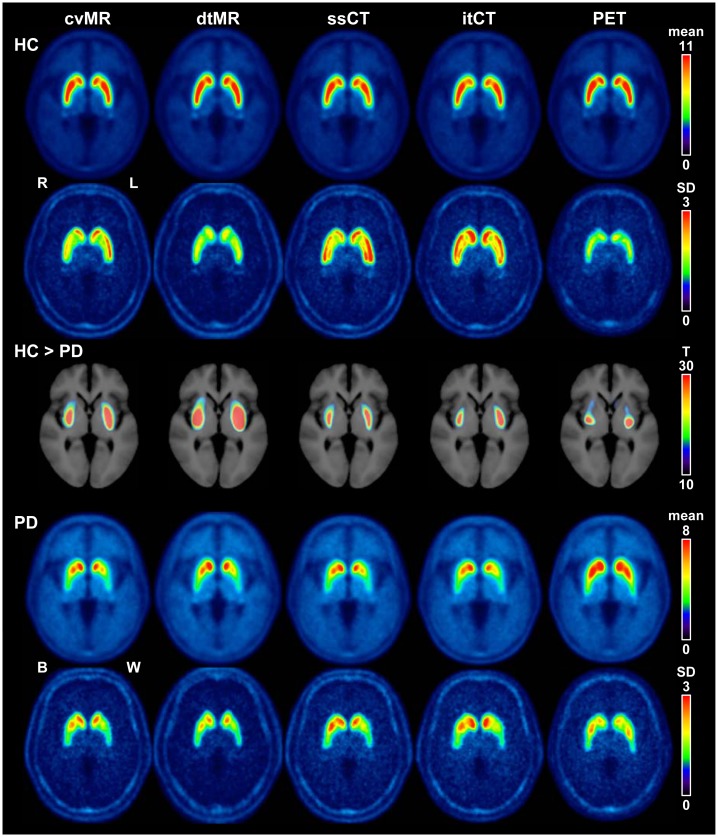
Mean and standard deviation (SD) images of each spatial normalization method and the results of voxel-based comparison between the healthy controls (HC) and Parkinson’s disease (PD) patients.For PD patients images were flipped to locate more affected side (contralateral to the clinically worse side; W) on the left (L) and the less affected side (contralateral to the clinically better side; B) on the right (R). The mean images of controls and PD patients derived from four structure-guided spatial normalization methods are similar. However, the caudate and anterior part of the putamen of PD patients were overestimated, and thereby, the mean image of PD patients derived from the PET-guided method shows higher uptake and in those regions. In contrast to the tendency shown in the mean images, the SD images of two CT-guided methods show higher SD values around the striatum, suggesting higher spatial variability. Voxel-based comparison between the controls and PD patients (family-wise error corrected) show the highest significance with the dtMR-guided method, and two CT-guided methods were inferior to the MR-guided methods. Color bars for mean and SD images represent standardized uptake value ratio (SUVR), and that for the voxel-based comparison images represents T-value for the comparison. Abbreviations: cvMR = MR-guided spatial normalization with conventional normalization tool, dtMR = MR-guided spatial normalization with DARTEL toolbox, ssCT = skull-stripped CT-guided spatial normalization, itCT = intensity transformed CT-guided spatial normalization, PET = PET-guided spatial normalization.